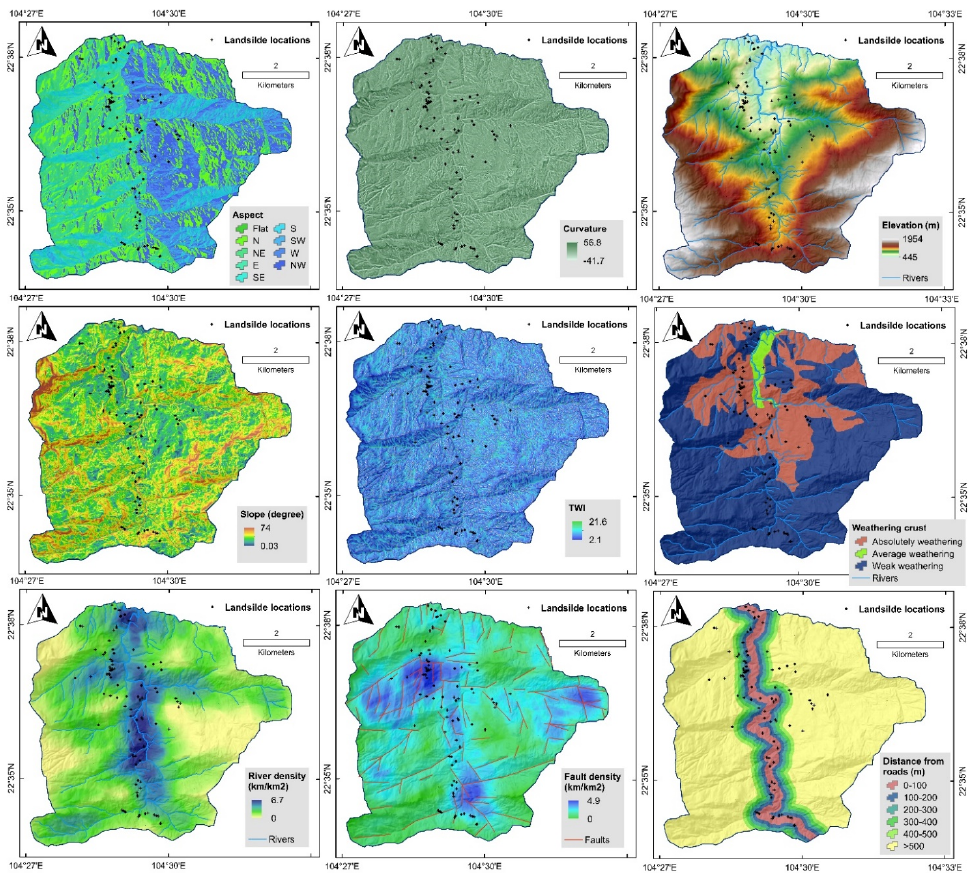
Figure 3. Thematic map of the landslide conditioning factors selected for the Nam Dan commune.